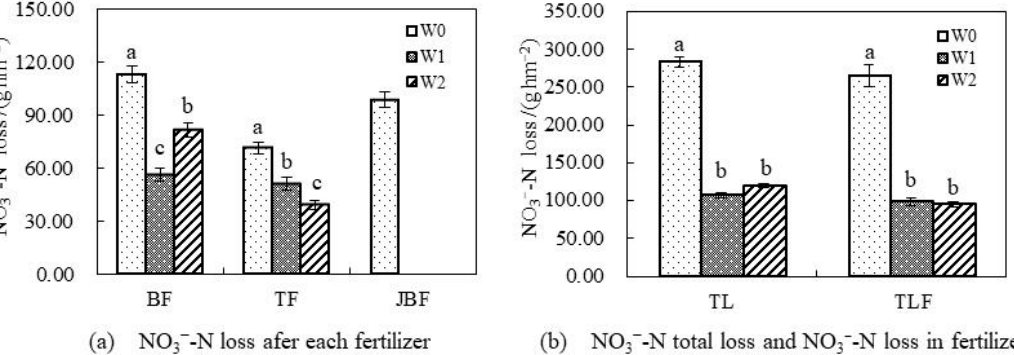
Figure 2. Changes of total NO 3 − -N leaching loss after fertilization under different irrigation modes, Figure a described the NO 3 − -N leaching loss after each fertilizer, and Figure b described NO 3 − -N total leaching loss and NO 3 − -N leaching loss in fertilizer. (BF, TF, JBF represented the base fertilizer, tilling fertilizer, and jointing-booting fertilizer, TL and TLF represented the NO 3 − -N total leaching loss and NO 3 − -N leaching loss in fertilizer, a, b and c in the figure represented differences between groups for significance analysis).